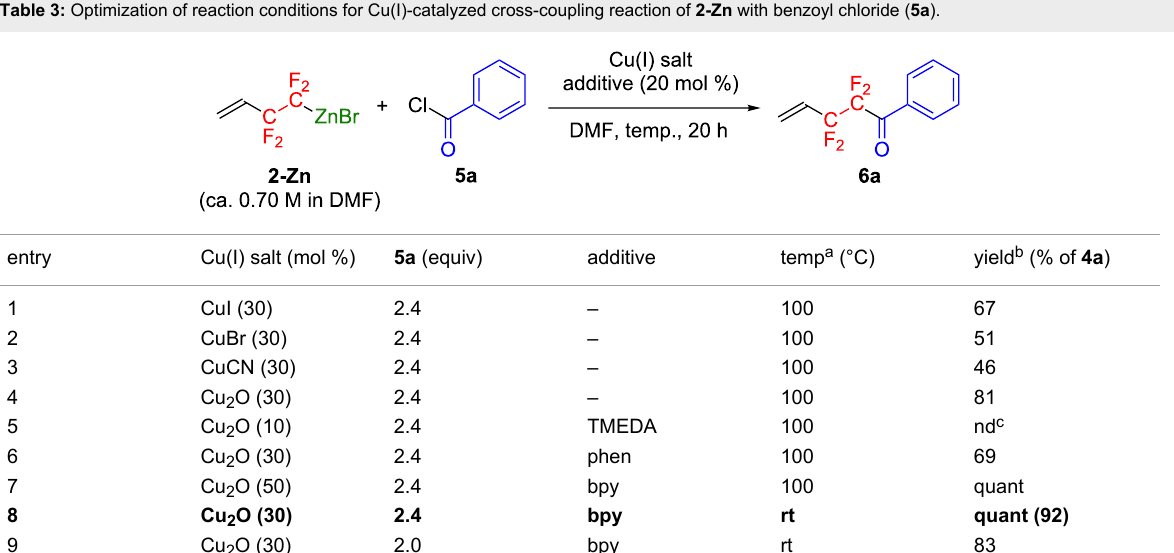
Table 3: Optimization of reaction conditions for Cu(I)-catalyzed cross-coupling reaction of 2-Zn with benzoyl chloride ( 5a ).